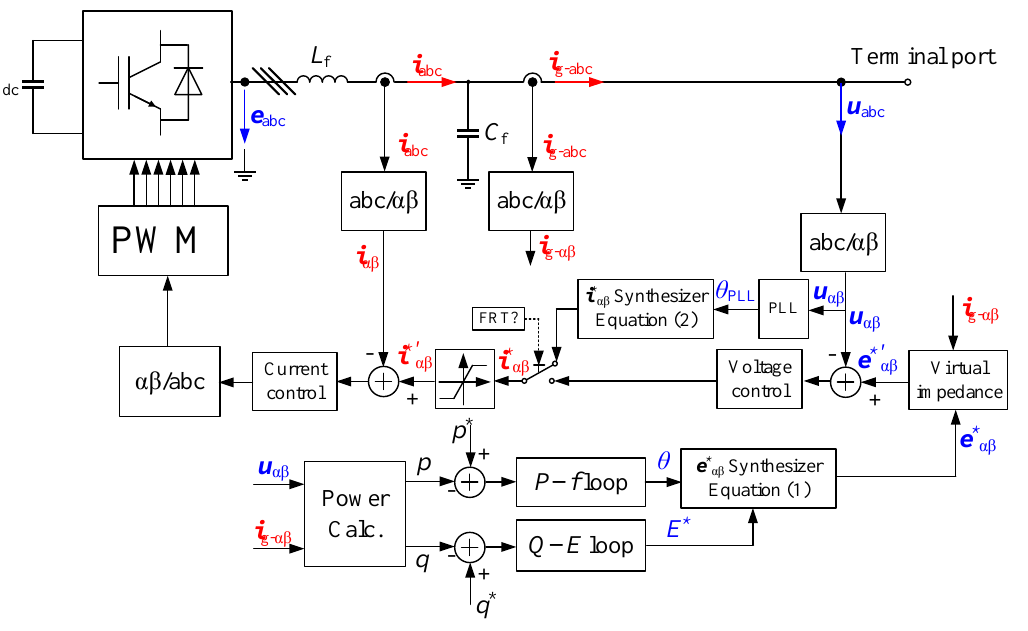
Figure 2. Complete control block diagram.